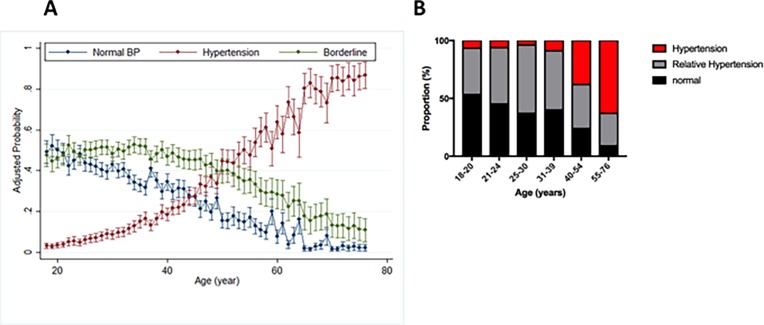
Trends in probability of having normal BP with advancing age (A) and stratification of study population by blood pressure categories and age (B). Relative hypertension is denoted in (A) as borderline hypertension. Blood Pressure values were adjusted for hemoglobin and WBC count.